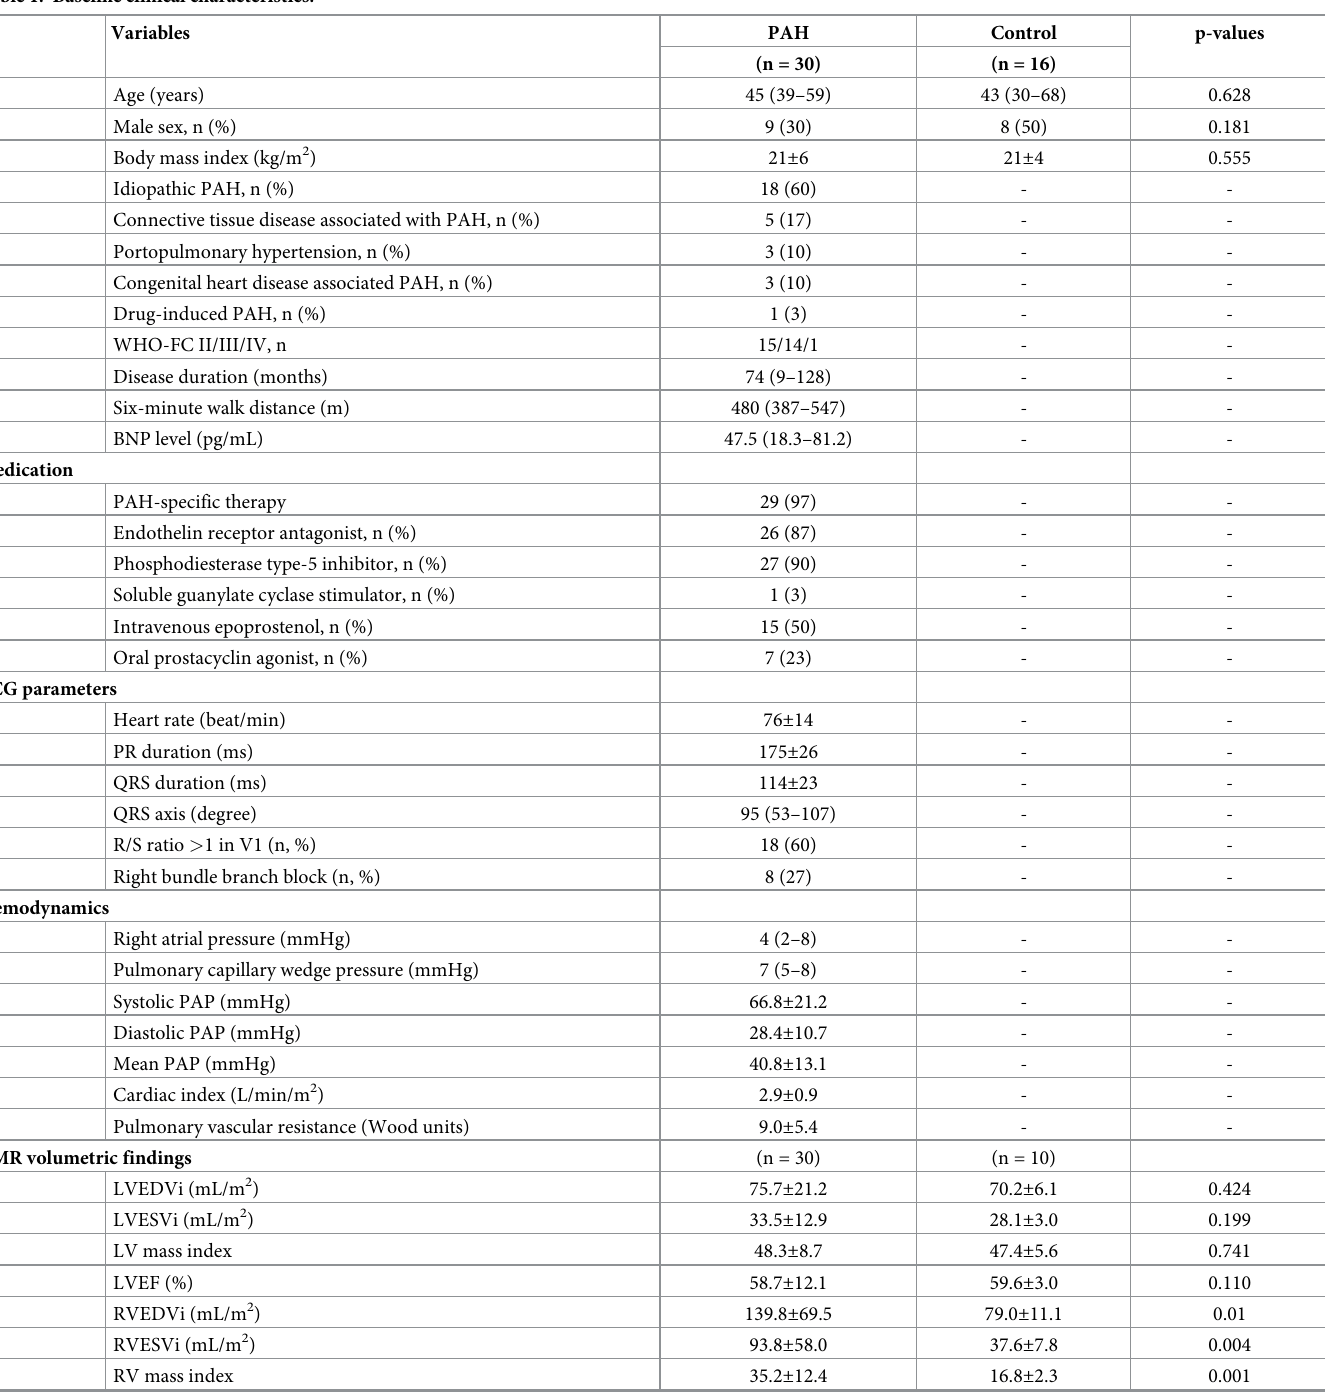
Table 1. Baseline clinical